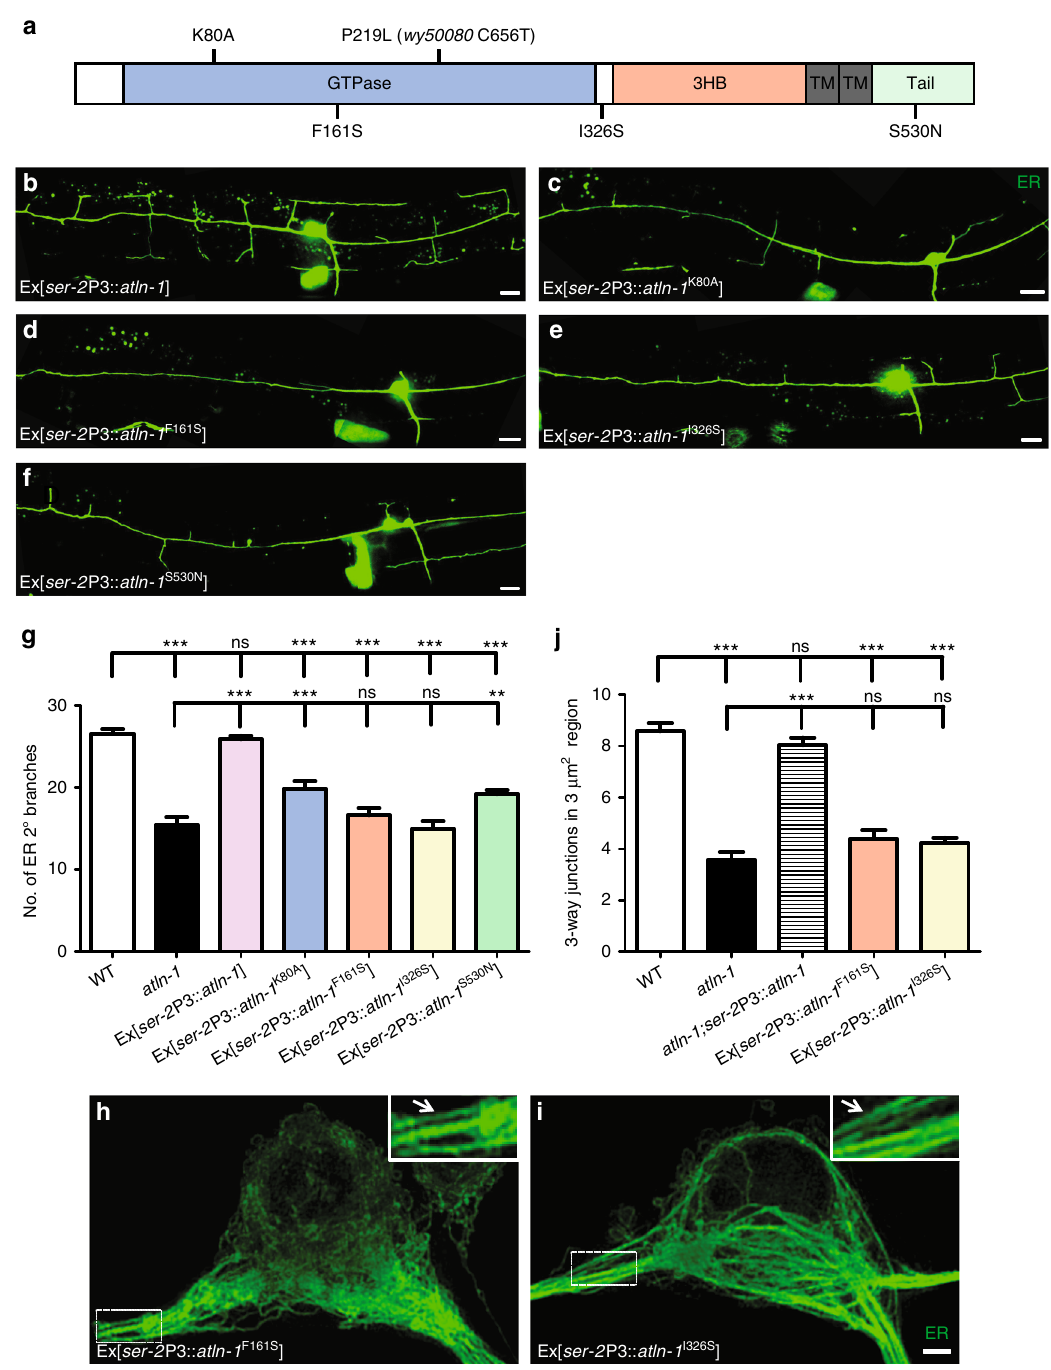
Fig. 8 HSP disease alleles of Atlastin-1 affect ER morphology. a Schematic diagram of ATLN-1 protein domains. K80A, wy50080 (P219L) and HSP related disease mutations are showed. b – f Representative ER morphology in Ex[ ser-2 P3:: atln-1 ] ( b ), Ex[ ser-2 P3:: atln-1 K80A ] ( c ), Ex[ ser-2 P3:: atln-1 F161S ] ( d ), Ex[ ser- 2 P3:: atln-1 I326S ] ( e ) and Ex[ ser-2 P3:: atln-1 S530N ] ( f ) transgenic adult worms. Scale bars, 10 μ m. g Quanti fi cation of ER 2° branches number. Values are mean and error bars are SEM, n = 40 – 50. ns, not signi fi cant; ** p < 0.01; *** p < 0.001 (Tukey ’ s multiple comparison test). h , i Representative maximum- intensity-projection 3D-SIM images of ER in PVD soma in Ex[ ser-2 P3:: atln-1 F161S ] ( g ) and Ex [ ser-2 P3:: atln-1 I326S ] ( h ) transgenic adult worms. Insets show 2X magni fi ed views. Scale bar, 1 μ m. j Quanti fi cation of 3-way junctions in a 3 μ m 2 region at anterior primary dendrite initiation segment (the dashed boxes in h and i ). Values are mean and error bars are SEM, n > 30. ns, not signi fi cant; *** p <0.001 (Newman-Keuls multiple comparison